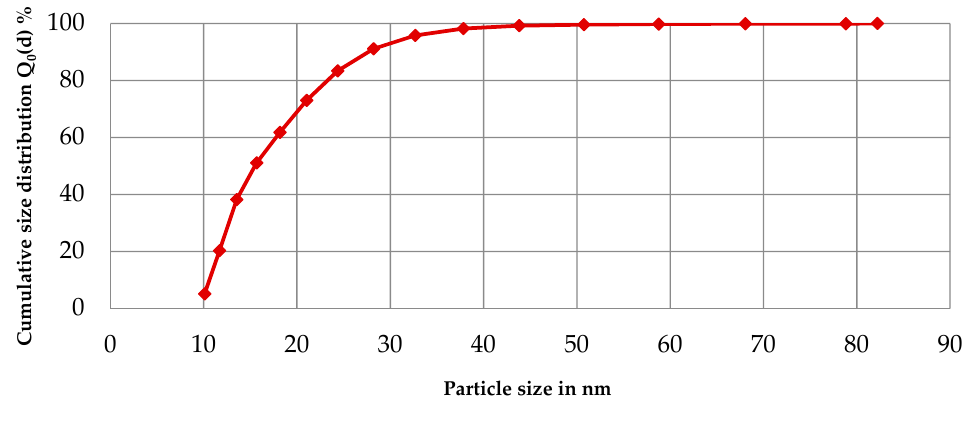
Figure 1. Cumulative size distribution Q 0 (d) for magnetite (z-average = 40 nm, PDI) = 0.37, and median particle size d 50, 0 = 16 nm).